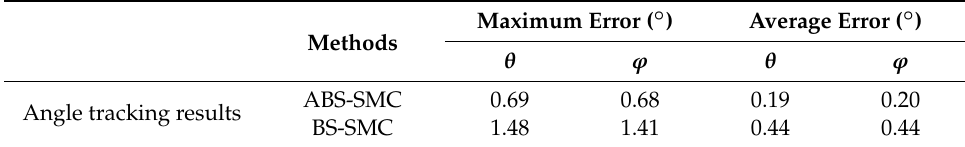
Table 2. Statistical analysis of end-effector angle tracking errors under different control methods (without subject).